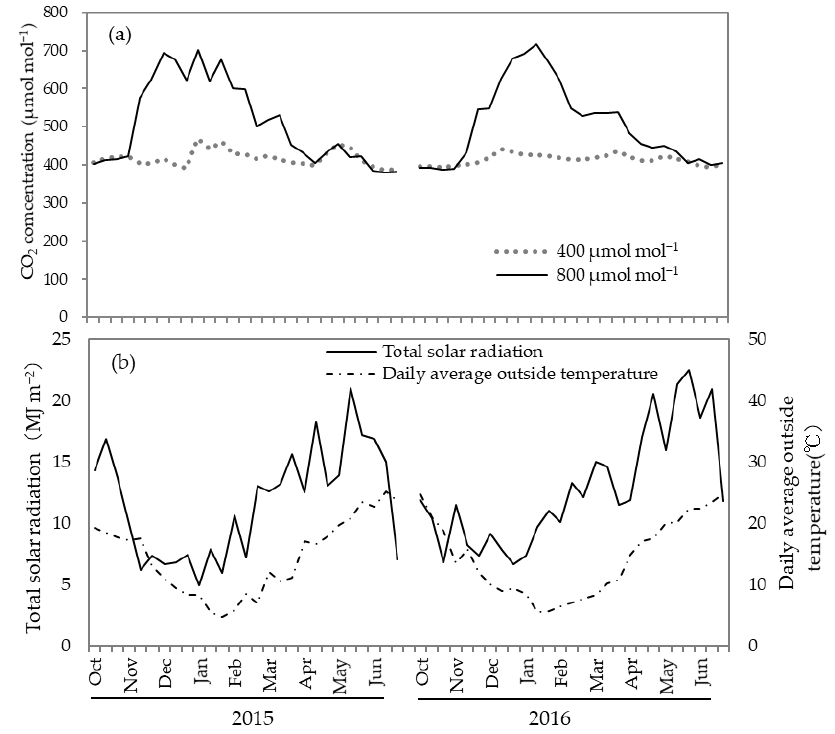
Figure 2. The change in average daytime CO 2 concentration ( a ), total solar radiation, and daily average outside temperature ( b ). Daytime means sunrise to sunset; 400 μmol mol −1 treatment where minimum CO 2 concentration is kept more than 400 μmol mol −1 in all day and 800 μmol mol −1 treat- ment where minimum CO 2 concentra tion is kept more than 800 μmol mol −1 during no ventilation and 400 μmol mol −1 during ventilation.